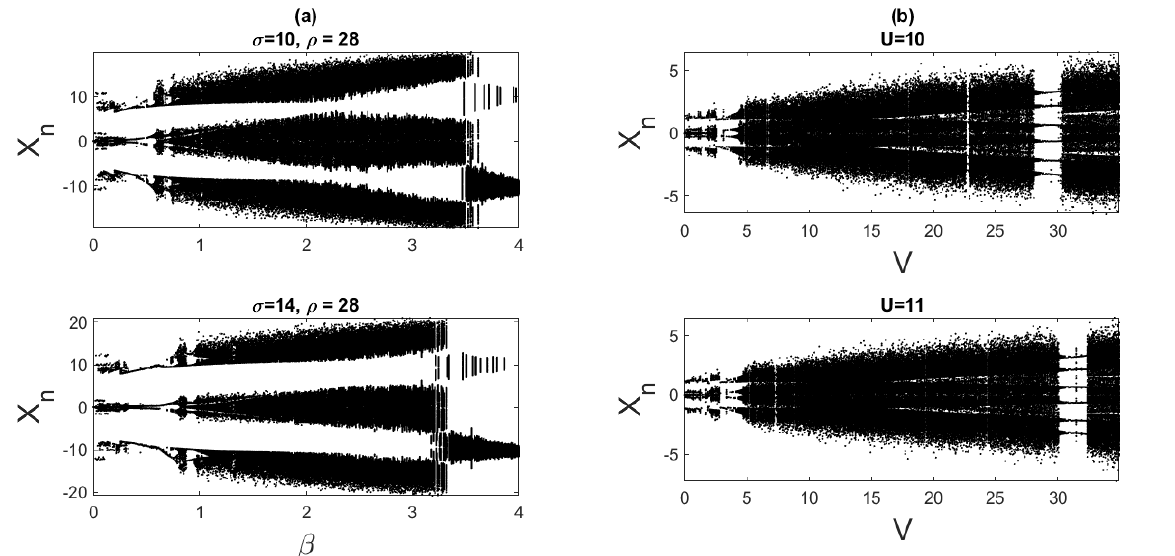
Figure 1. Bifurcation plot of ( a ) the Lorenz system with varying parameter β and ( b ) the Burke–Shaw system with varying parameter V